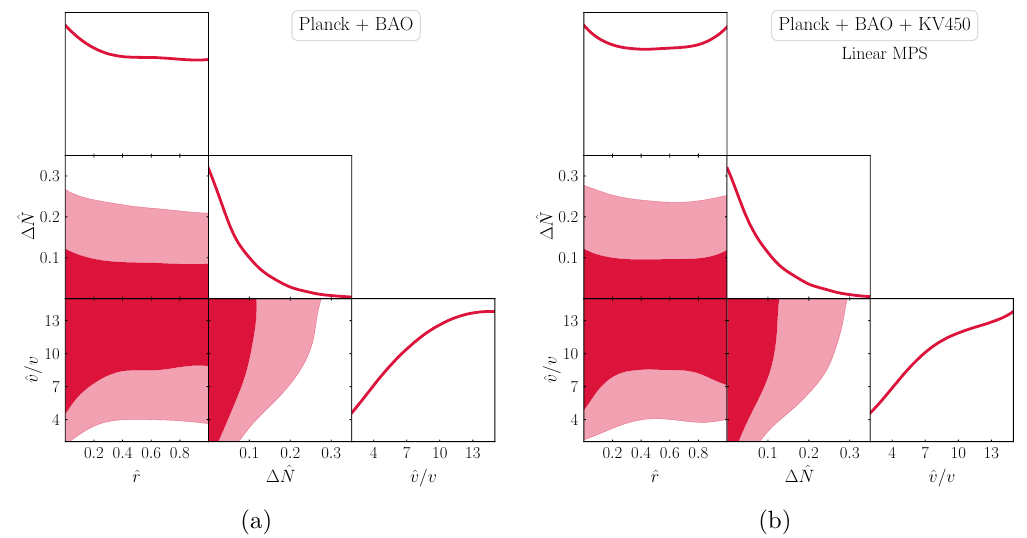
Figure 21. Constraints on all three MTH parameters using the Planck+BAO (left) and Planck+BAO+KV450 (right)